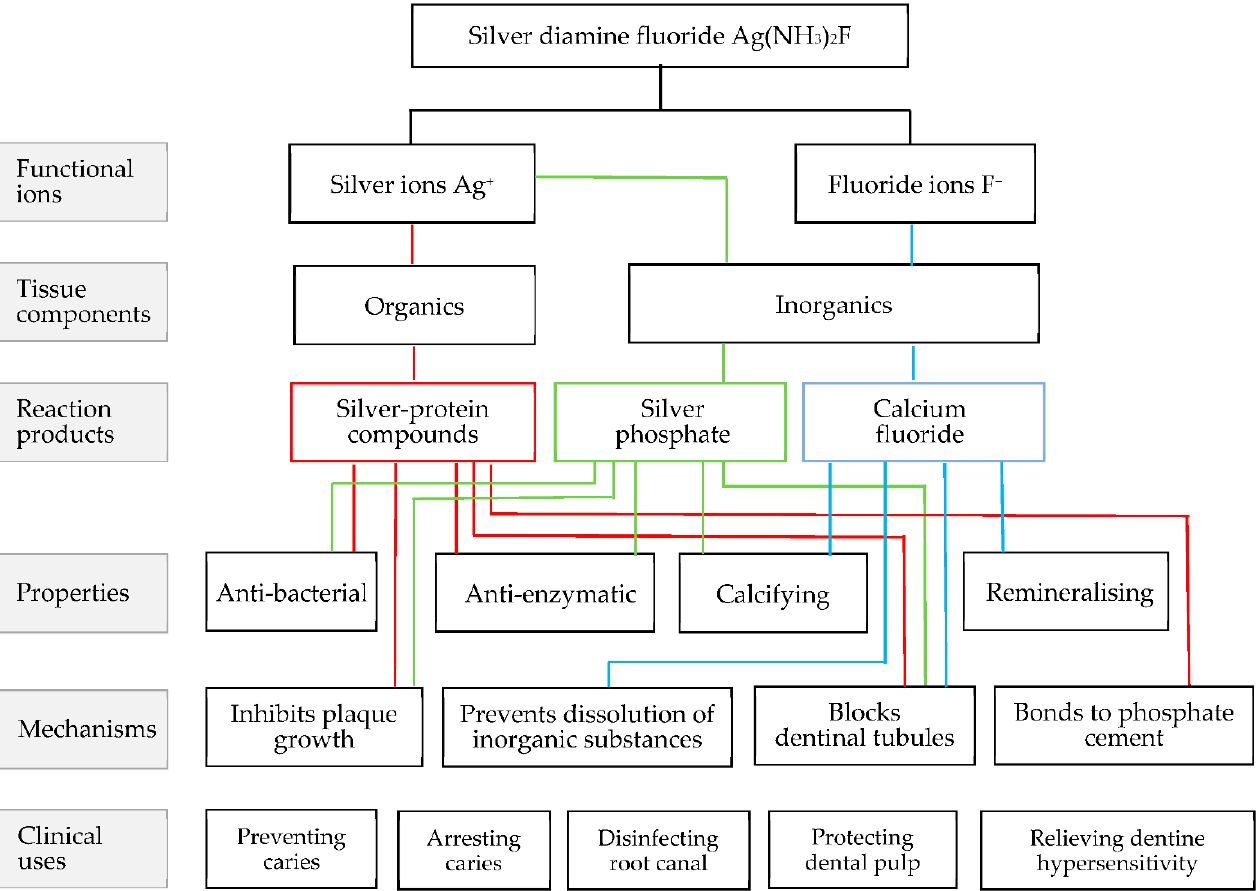
Figure 1. Functional ions, reaction products, properties, mechanisms and clinical uses of SDF per Yamaga.